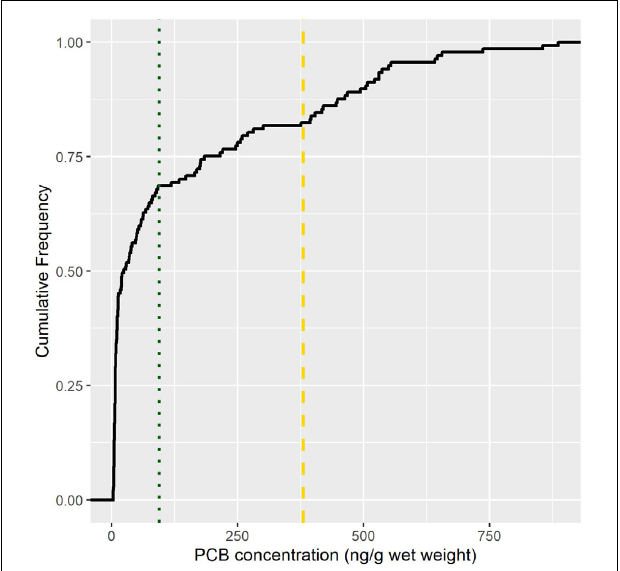
FIGURE 5 | Cumulative proportion of stream-resident trout PCB concentrations (ng/g wet weight) that exceed EPA cancer (dashed line) and non-cancer causing (dotted line) end points. Cancer end points exceed 380 (ng/g wet weight) while non-cancer exceed 94 (ng/g wet weight). Non-cancer health endpoints may include immune, reproductive, neurological, or endocrine impairments. All fish included in this analysis were sampled in streams draining to Lake Michigan or Huron that receive annual salmon runs. Data source: Gerig,